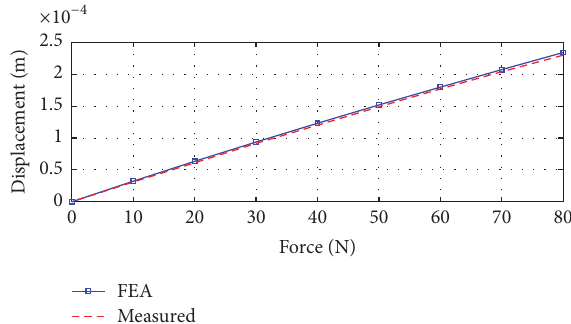
Figure 8: Deformation of the motor module in the direction of the transmission: comparison between experimental values and